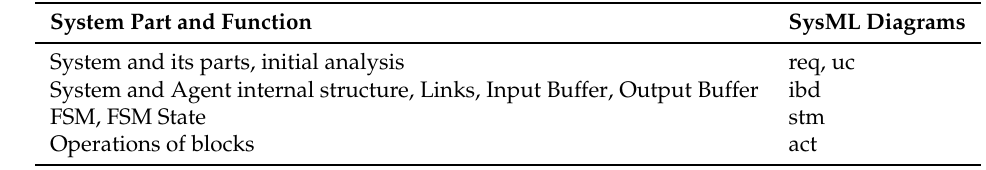
Table 3. SysML diagrams describing system parts in EARL.